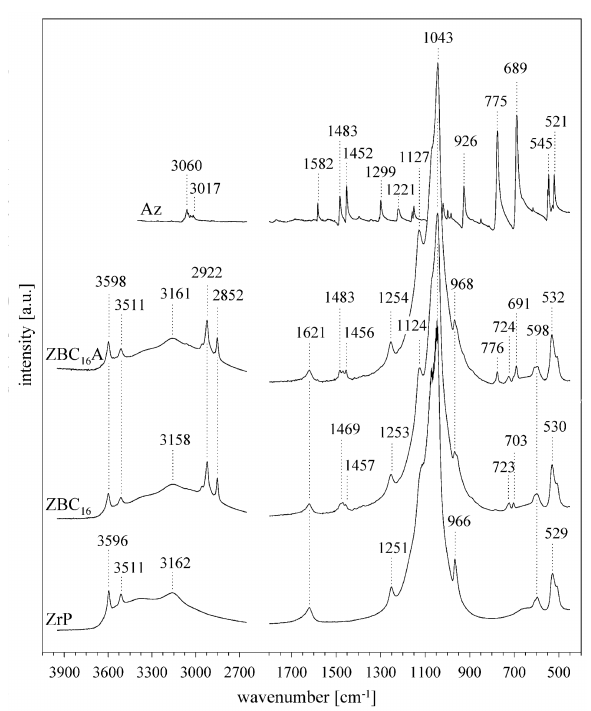
Figure 2. FTIR spectra of pure ZrP sample, ZBC 16 , ZBC 16 A intercalates, and azobenzene (Az).